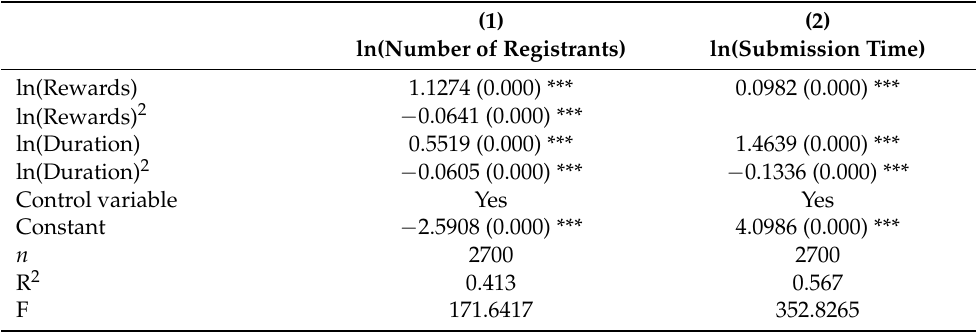
Table 7. Results of robustness